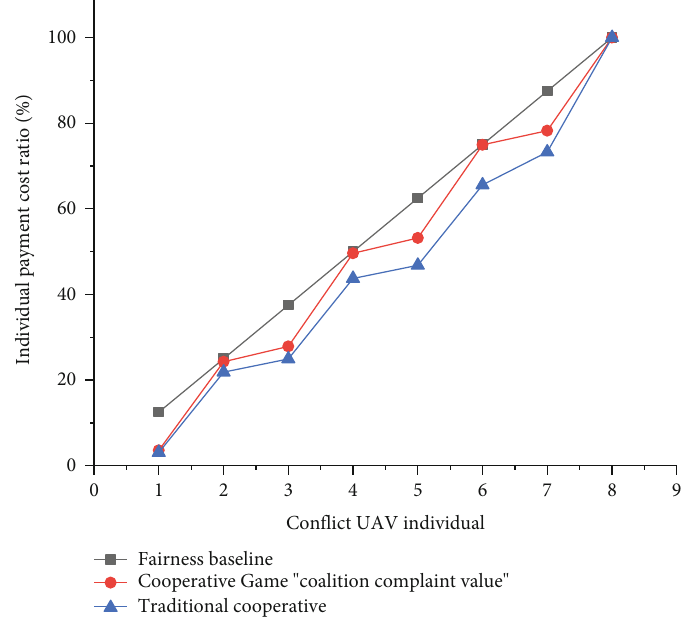
Figure 16: Comparison of individual fairness between the two solutions under scenario 3.